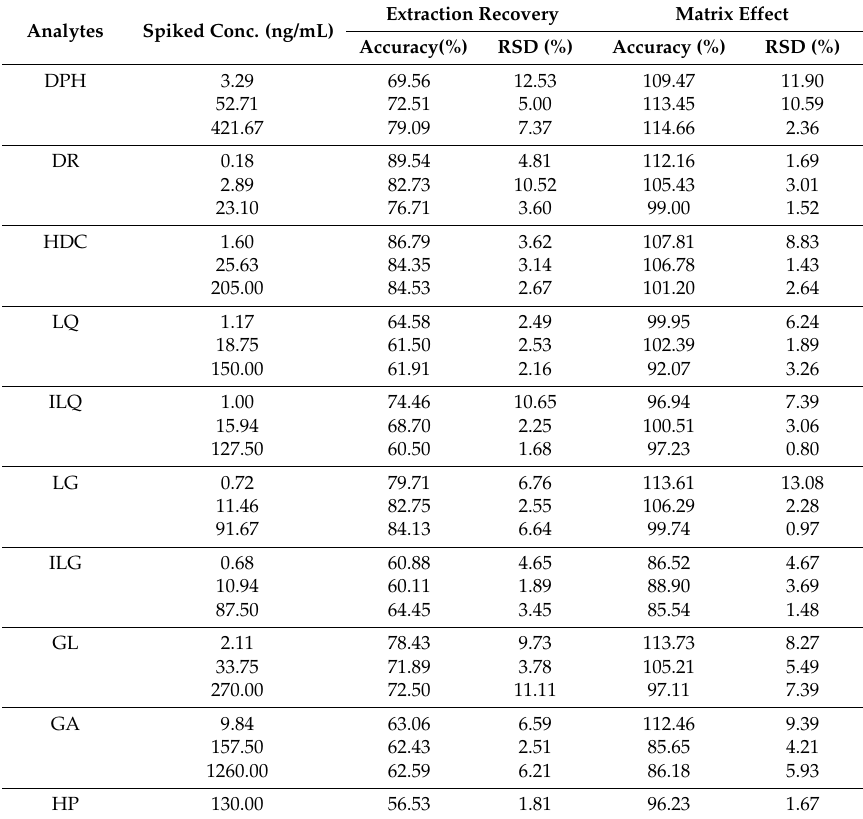
Table 3. The extraction recovery and matrix effect of DPH, DR, HDC, LQ, ILQ, LG, ILG, GL, GA, and HP in rat